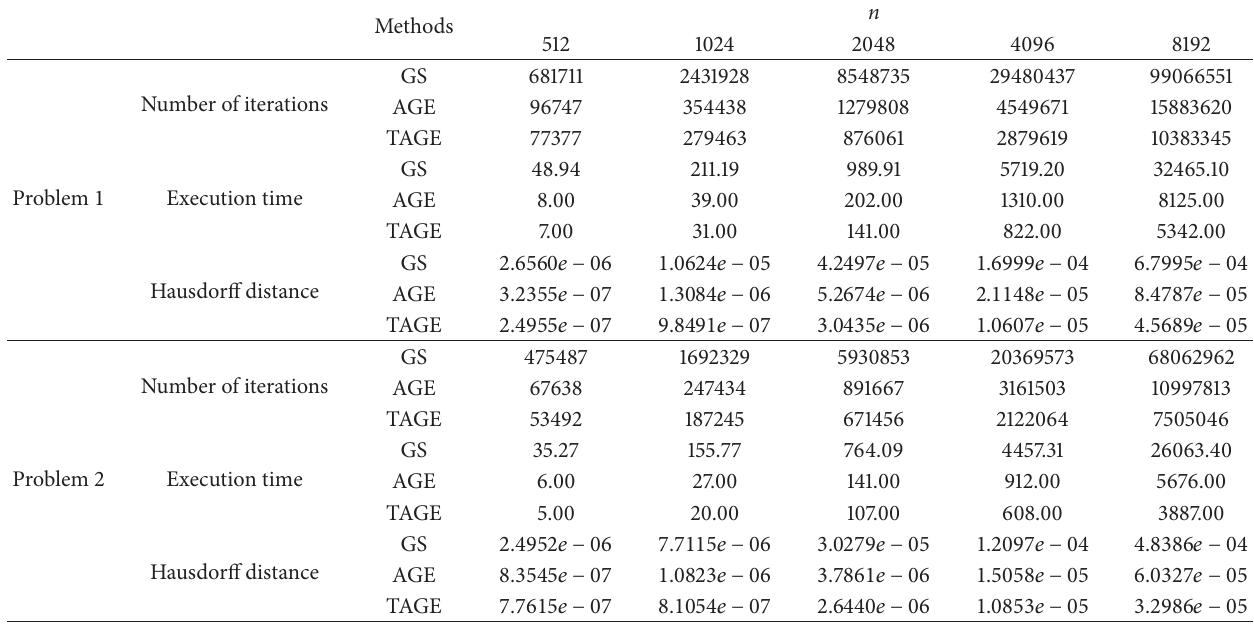
Table 1: Comparison of three parameters between GS, AGE, and TAGE methods at 𝛼 = 0 . 00.